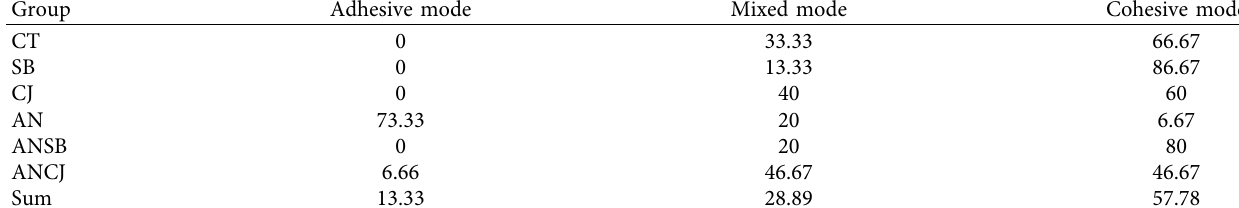
Table 3: Modes of